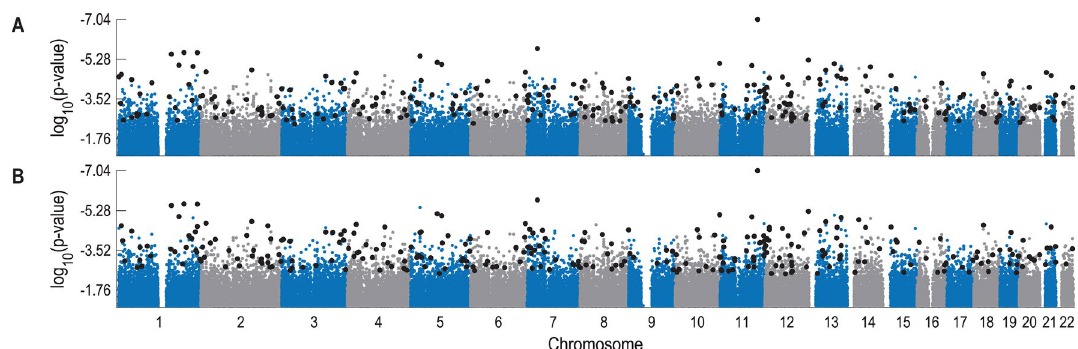
Figure 2. Log 10 ( pvalue ) of SNPs associated with lung cancer risk based on the data from phs000634. Small blue or gray dots denote all of the 656,891 SNPs with log 10 ( p value ) not larger than − 1 ; large black dots denote the SNPs used in our NBC models. ( A ) Result of NBC (1) 634 . ( B ) Result of NBC (2) 634